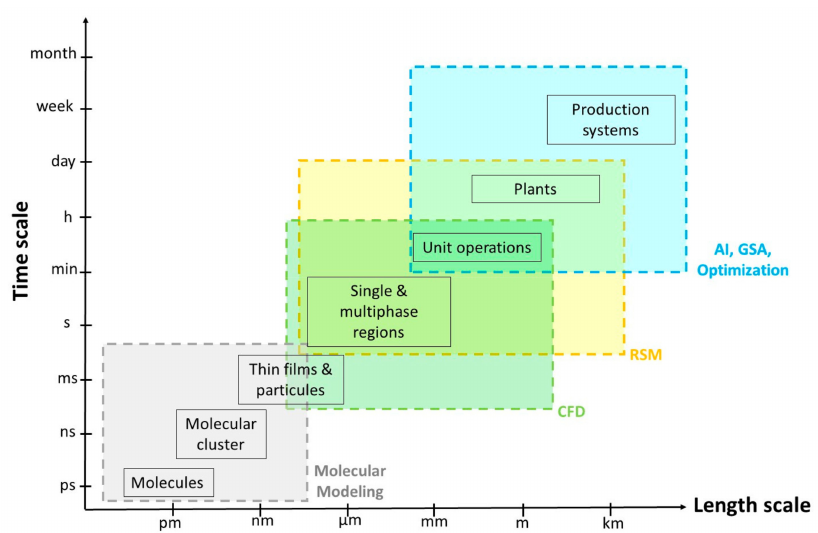
Figure 1. Levels of length and time alongside the modeling and optimization tools analyzed in this manuscript (CFD—computational fluid dynamics; RSM—response surface methodology; AI—artificial intelligence; GSA—global sensitivity